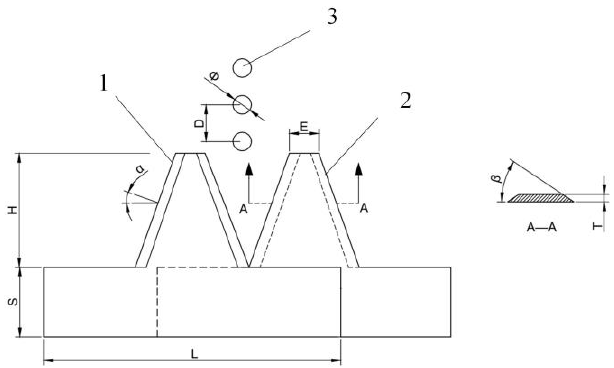
Figure 3. The structural diagram of the geometric model: 1—upper cutting blade; 2—bottom cutting blade; 3—stalk.